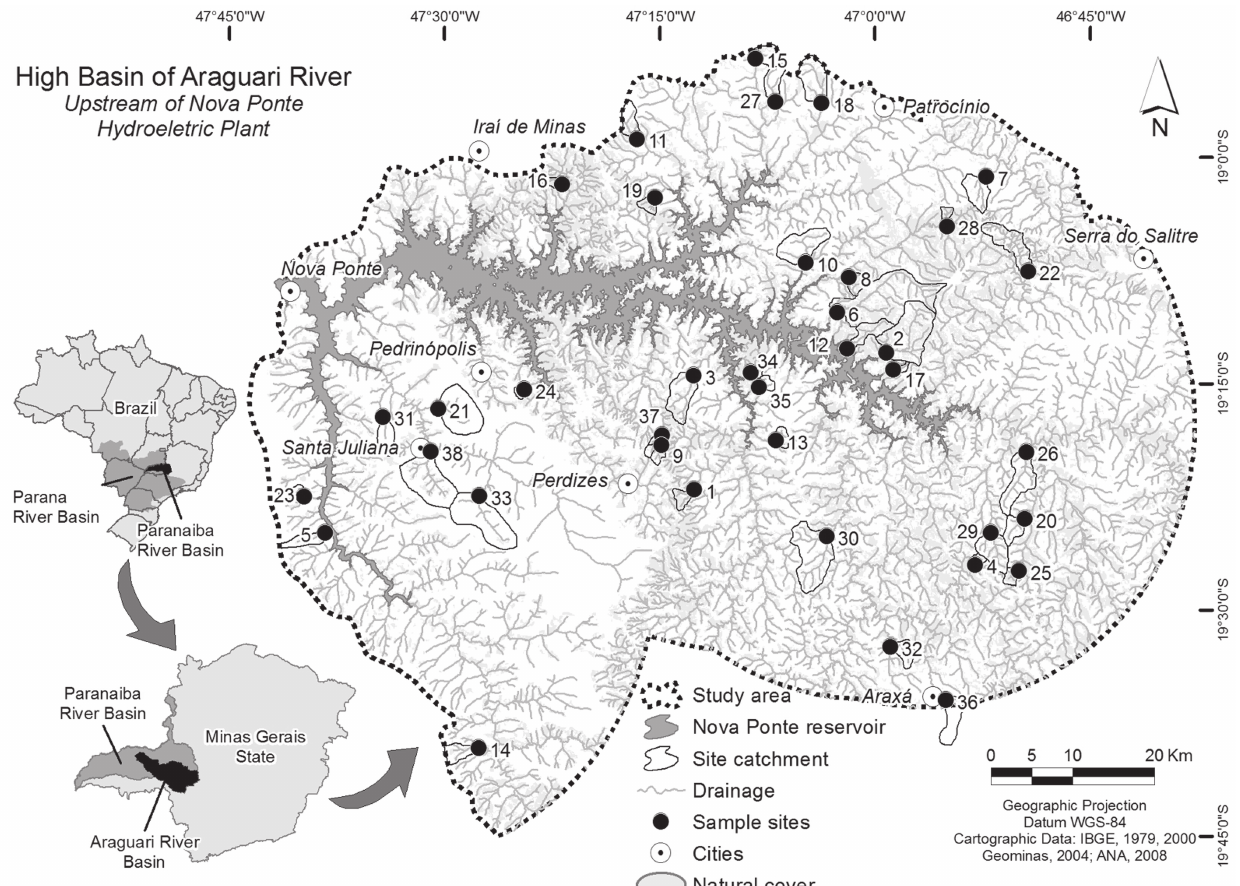
Fig. 1. Locations of the 38 randomly selected sites sampled in the Upper Araguari River basin, State of Minas Gerais,